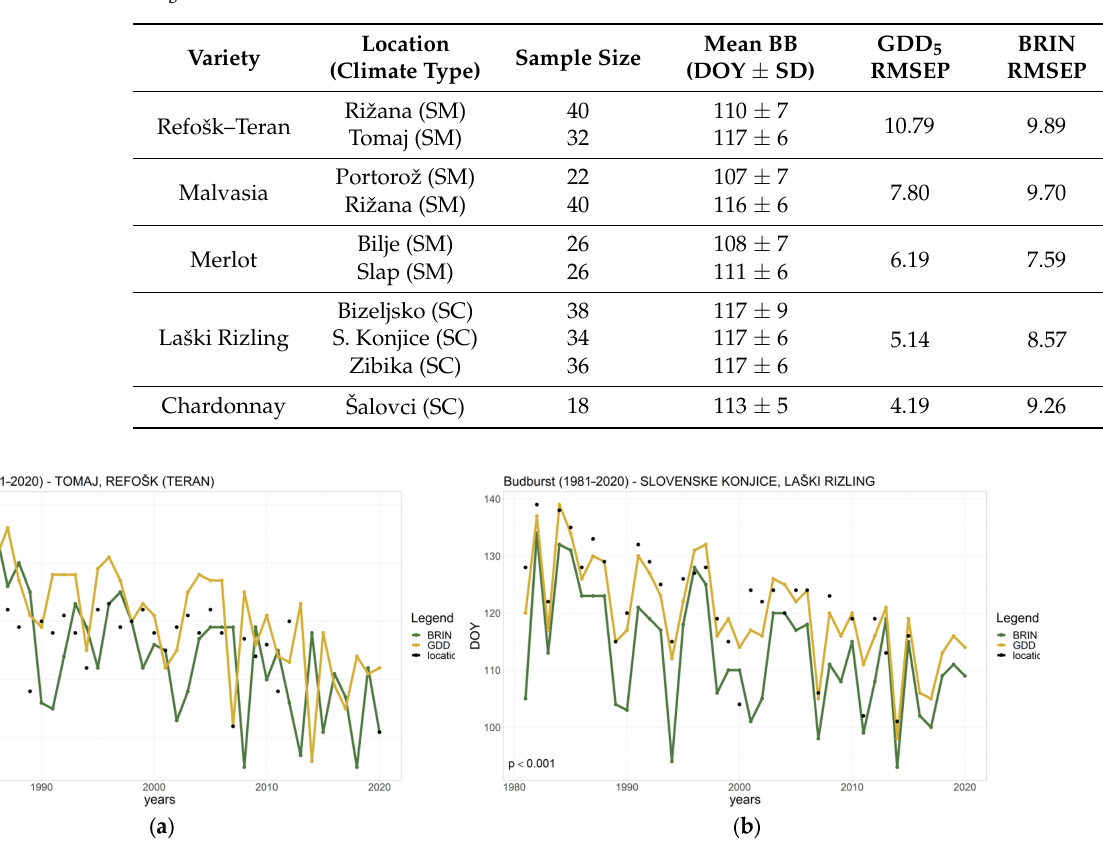
Figure 2. Modeled and observed budburst dates of two grapevine varieties: ( a ) Refošk–Teran variety at location Tomaj (sub-Mediterranean climate); and ( b ) Laški Rizling variety at location Slovenske Konjice (subcontinental climate). Yellow lines indicate results obtained with GDD, green lines indicate results obtained with BRIN, and black dots indicate the observed budburst date according to the Slovenian Environment Agency dataset. Added is the statistical significance (p) of the trend in observed budburst dates, calculated with the Mann–Kendall test, and day of year is denoted as